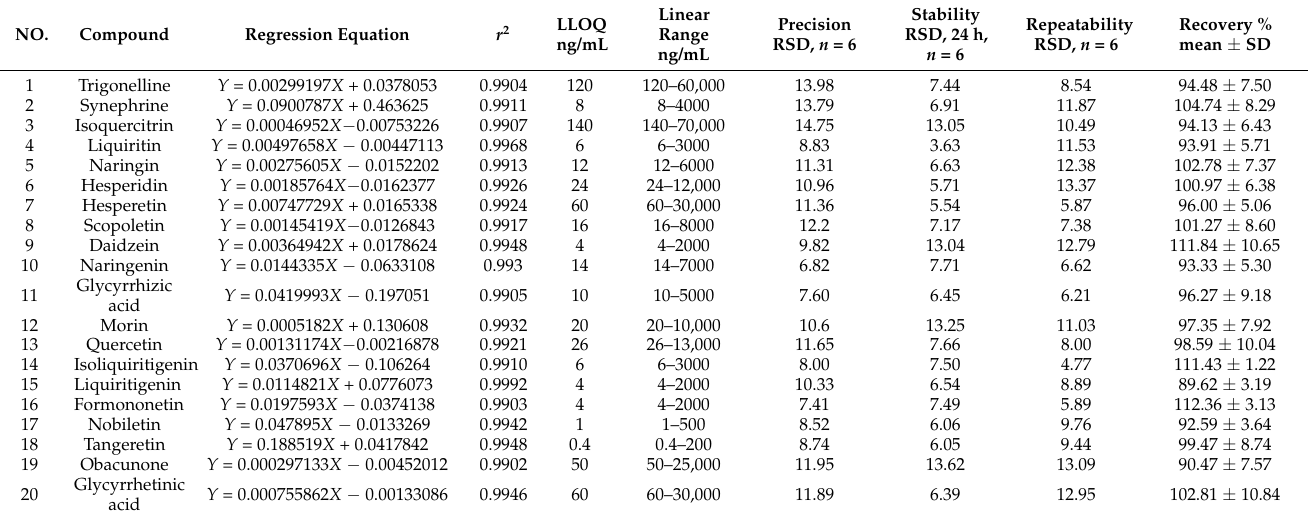
Table 3. Regression data, LLOQs, precision, stabilities and repeatabilities for the 20 components of